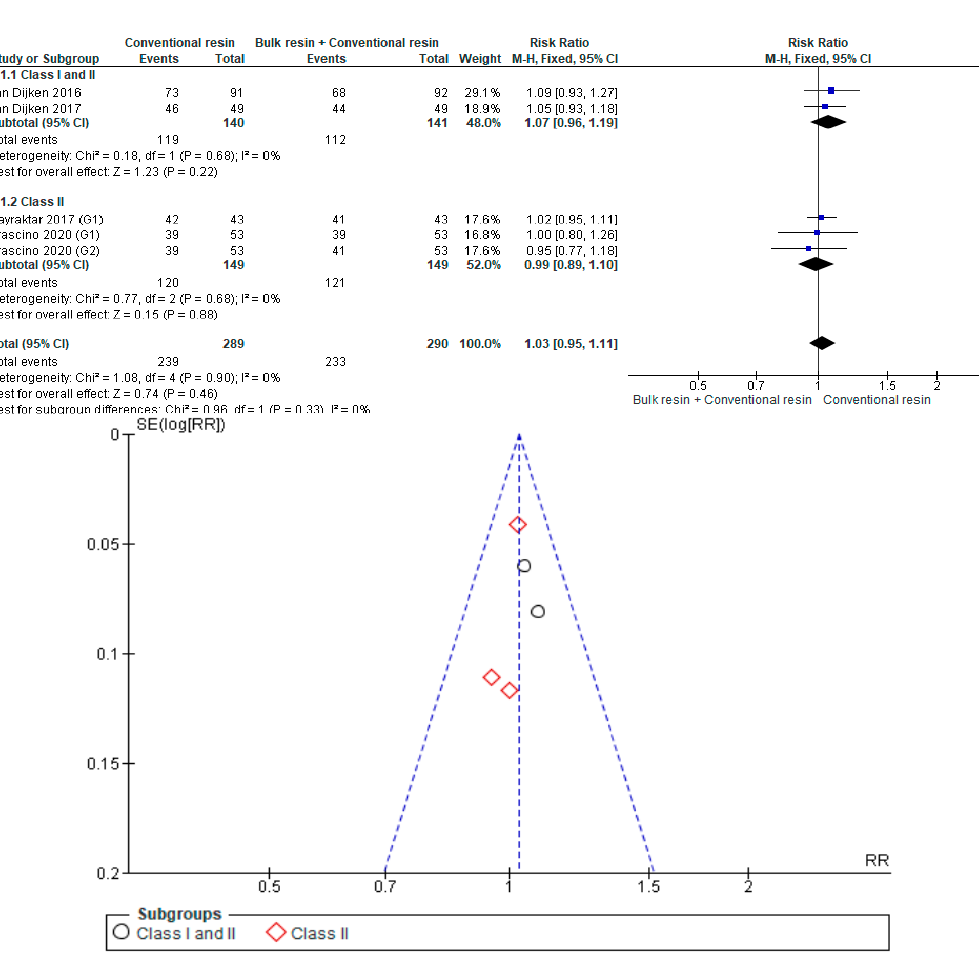
Figure A6. Absence of Discoloration or Marginal Staining: Conventional Resin versus Bulk Resin Covered with Conventional Resin According to Type of Restoration.